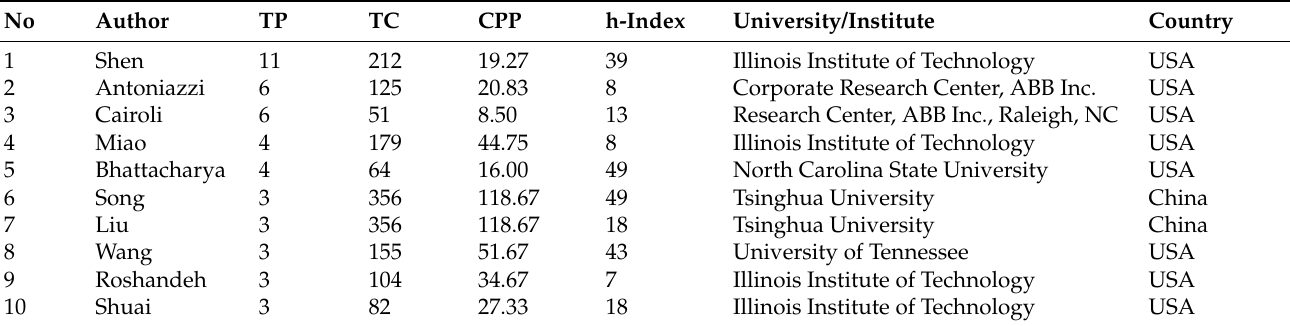
Table 7. Top Ten Lists of Most Influential